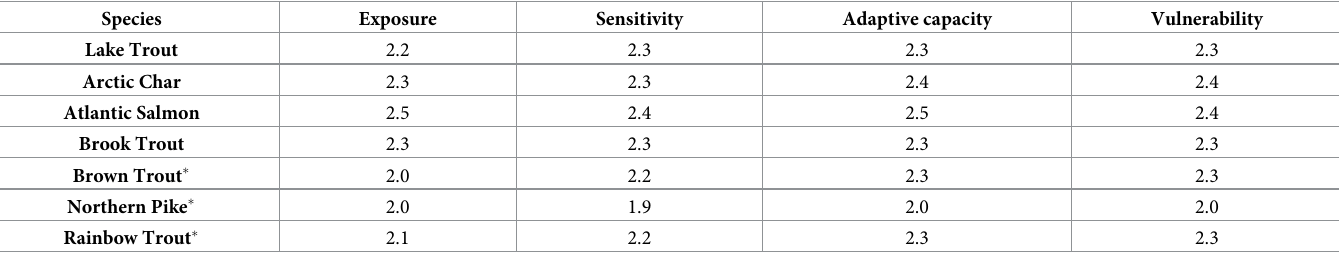
Table 3. Average expert confidence scores (n = 8). A scale of 1–3 (where 1 = low confidence, 2 = medium confidence and 3 = high confidence) was used to represent expert confidence. The confidence ratings across all indicators were averaged to derive the final confidence scores, for all vulnerability components (exposure, sensitivity, and adaptive capacity). � indicates non-native species.